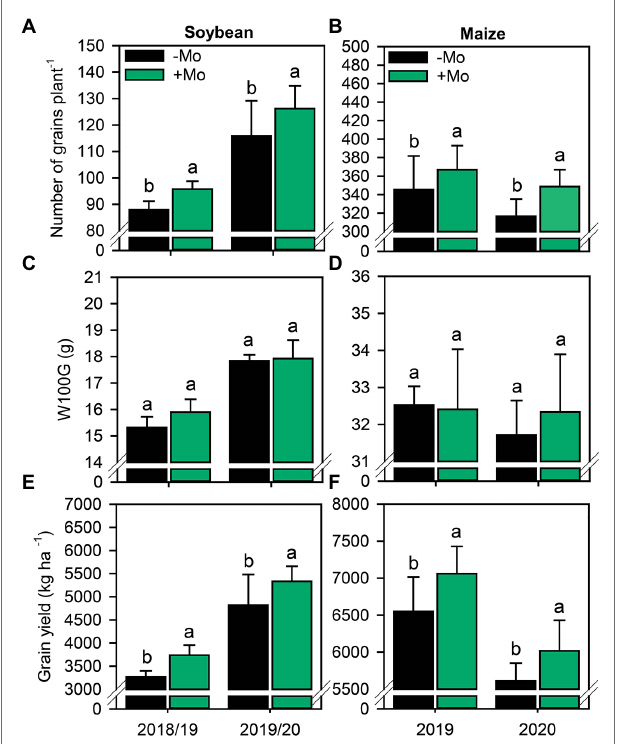
FIGURE 8 | Heatmap of Pearson’s Correlation coefficients. Nitrogen (N), Phosphorus (P), Potassium (K), calcium (Ca), Magnesium (Mg), sulfur (S), Molybdenum (Mo), Boron (B), Iron (Fe), Copper (Cu), Manganese (Mn), Zinc (Zn), Nitrate reductase active (NRa), Total nitrate reductase (NRt), PEP carboxilase (PEP), Rubisco (Rub), Net photosynthesis rate (A), stomatal conductance ( gs ), internal CO 2 concentration ( Ci ), leaf transpiration ( E ) water use efficiency (WUE), carboxylation efficiency ( A/Ci ), Protein (Prot), leaf total sugar concentration (TS), Shoot nitrogen concentration (SNC), Shoot dry matter (DM), Shoot nitrogen accumulation (NA), Prolificacy (Pf), number of rows per ear (NR), number of grains per rows (NGR), number of grains per ear (NGE), number of pods per plant (NPP), number of grains per plant (NGP), mass of 100 grains (W100G), and grain yield